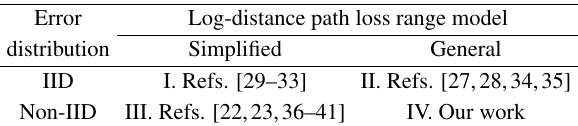
Table 1 Classification of the